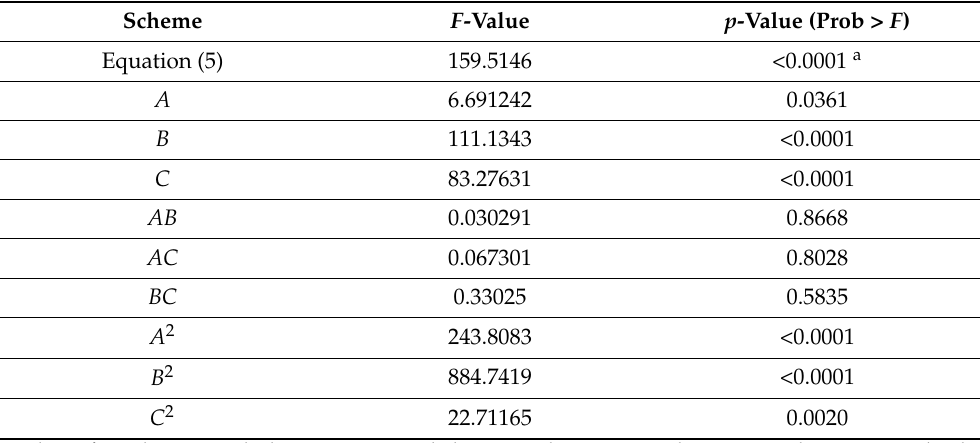
Table 3. ANOVA of response quadratic model analysis for the β Co/Ni. .